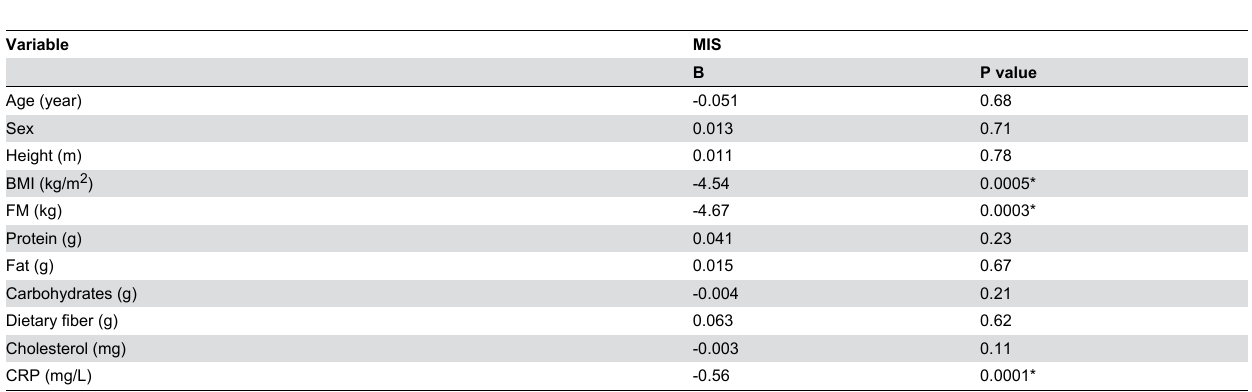
Table 3. The multivariate regression analysis among MIS and anthropometric measurements, dietary macronutrients, and